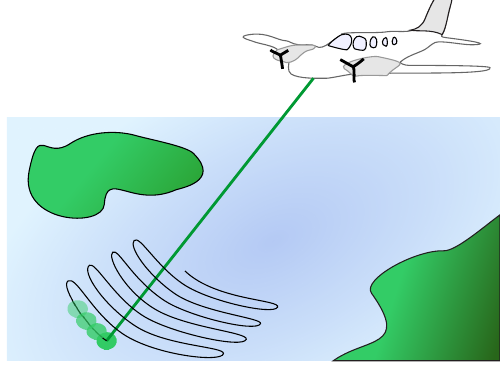
Figure 3. HawkEye II scanning pattern.